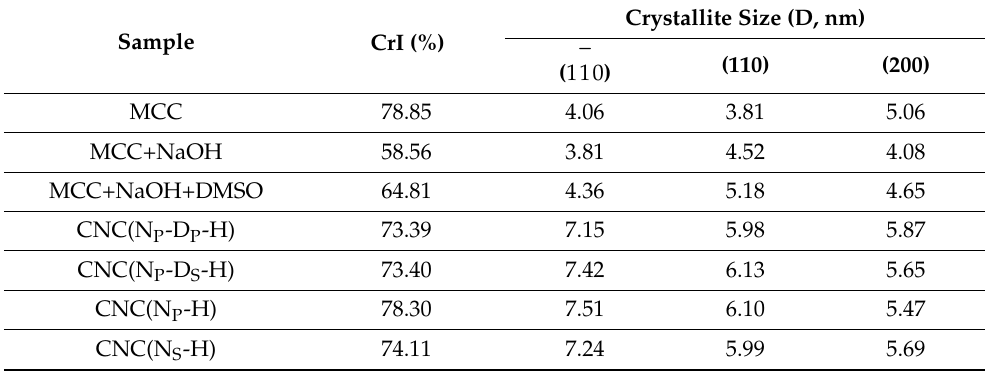
Table 1. The crystallinity and crystallite size for different samples.